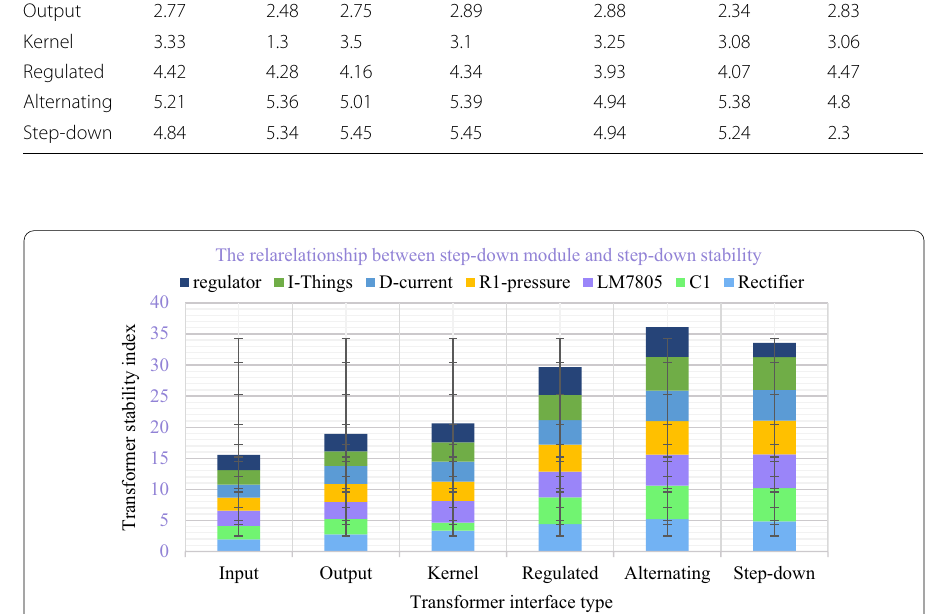
Fig. 3 The relationship between step-down module and step-down